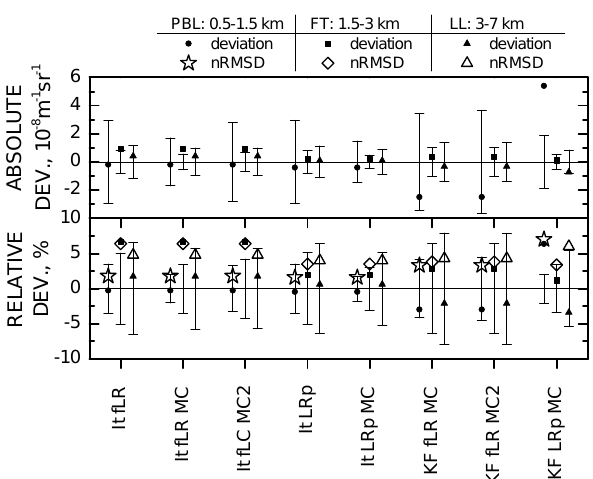
Figure 14. Same as Fig. 12, but for particle backscatter coefficient profiles at 1064nm and with fixed lidar ratio values of 85 ± 10sr. Raman profiles are not available for this